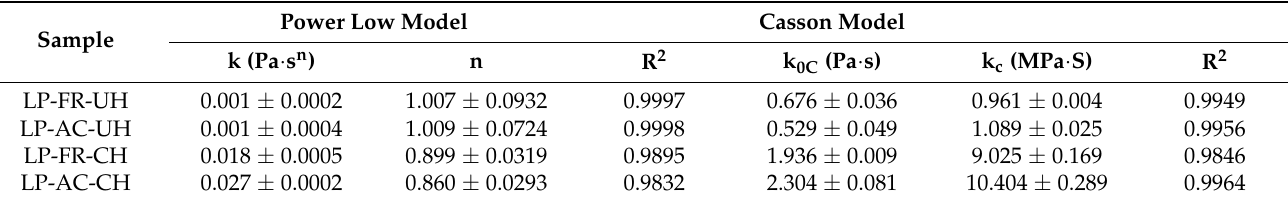
Table 3. Rheological characteristics of various nanoliposome